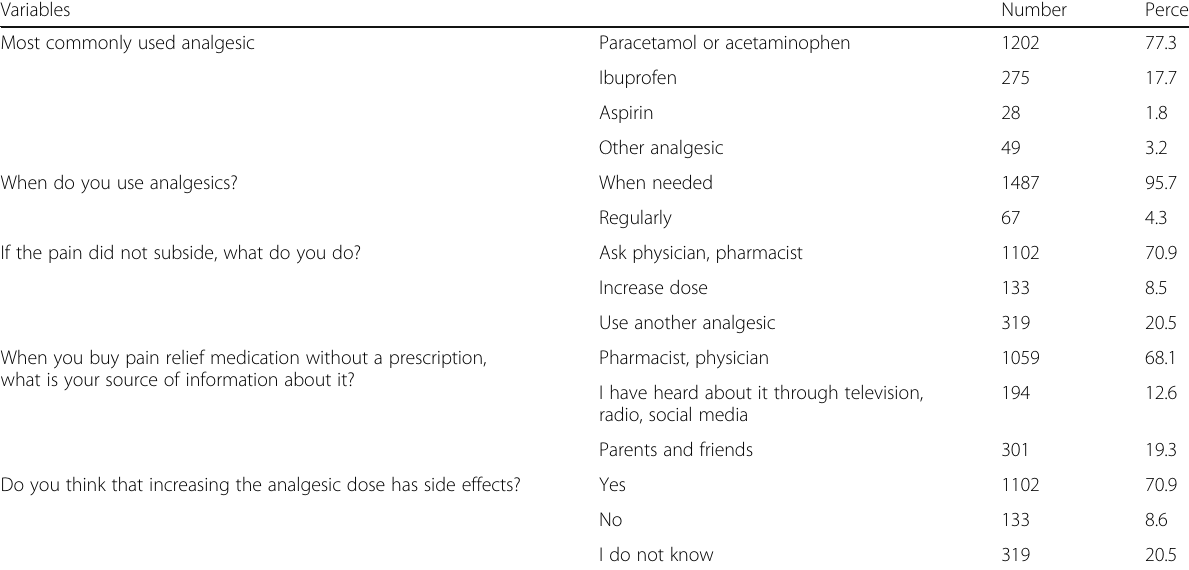
Table 2 Knowledge and awareness of participant about analgesics ( n = 1554) Variables